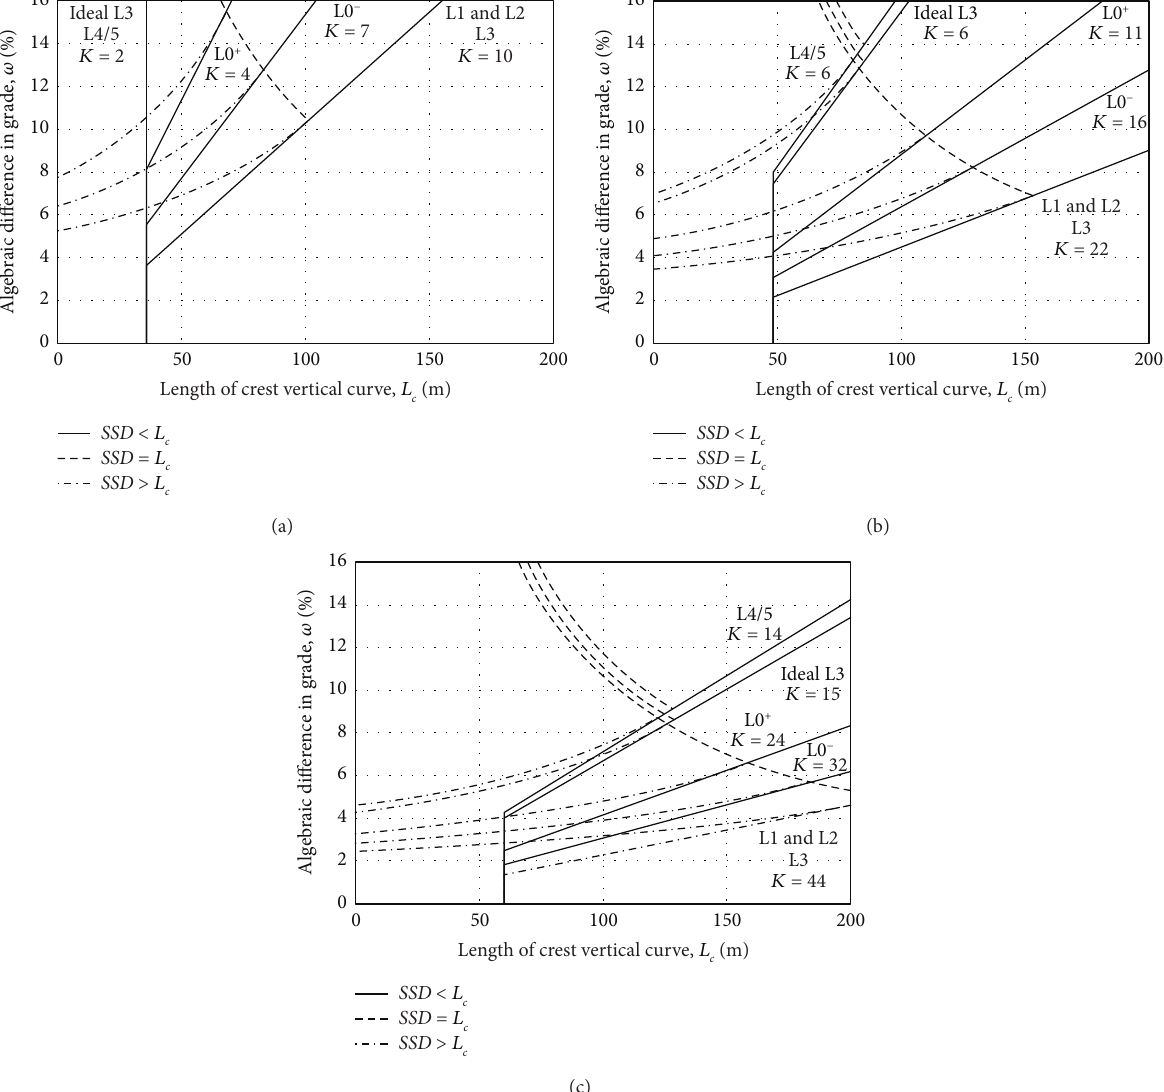
Figure 6: Design controls for crest vertical curves for all scenarios: (a) V � 60km/h; (b) V � 80km/h; (c) V � 100